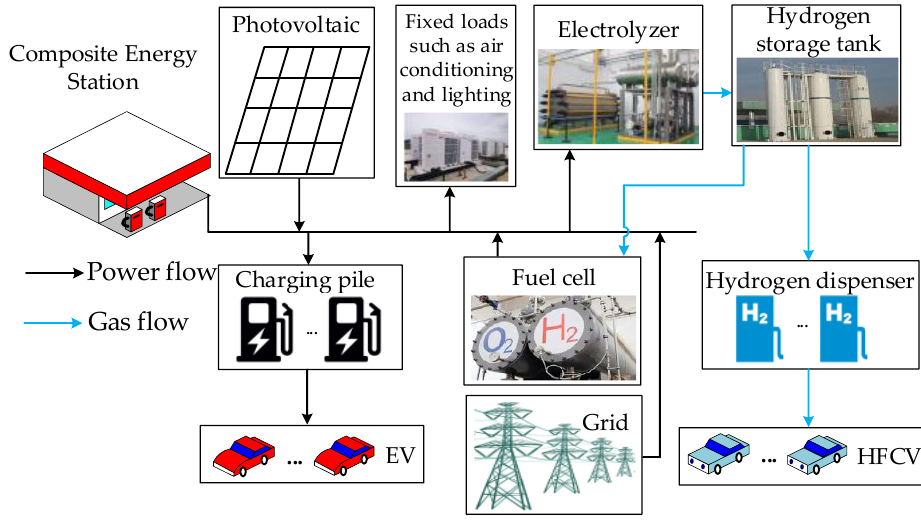
Figure 1. CES system structure.